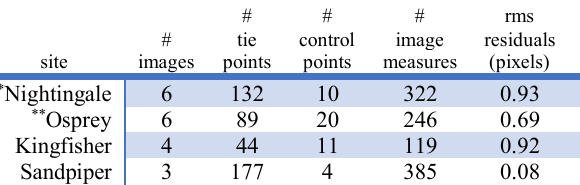
Table 4. Bundle adjustment statistics for final four candidate sample sites (single and double asterisks indicate the selected primary and secondary sample sites respectively).